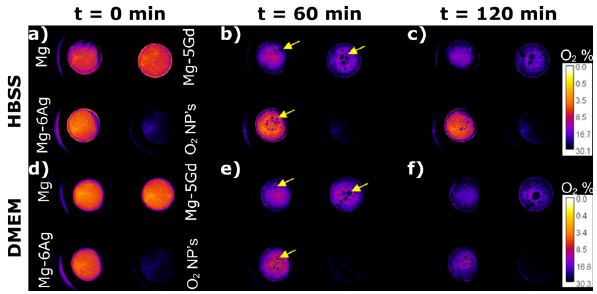
Fig. 2 Images of O 2 concentration over the metal disc surface. a – c shows the degradation of the discs in HBSS and d – f in DMEM. The images were acquired at time 0 min ( a , d ), 60 min ( b , e ) and 120 min ( c , f ) after adding the respective solution containing O 2 - sensitive nanoparticles. All sample types showed the development of gas bubbles (arrows) over the measured duration. The image contrast was adjusted for better